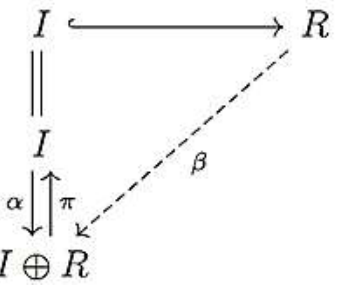
Diagram 13: A module is